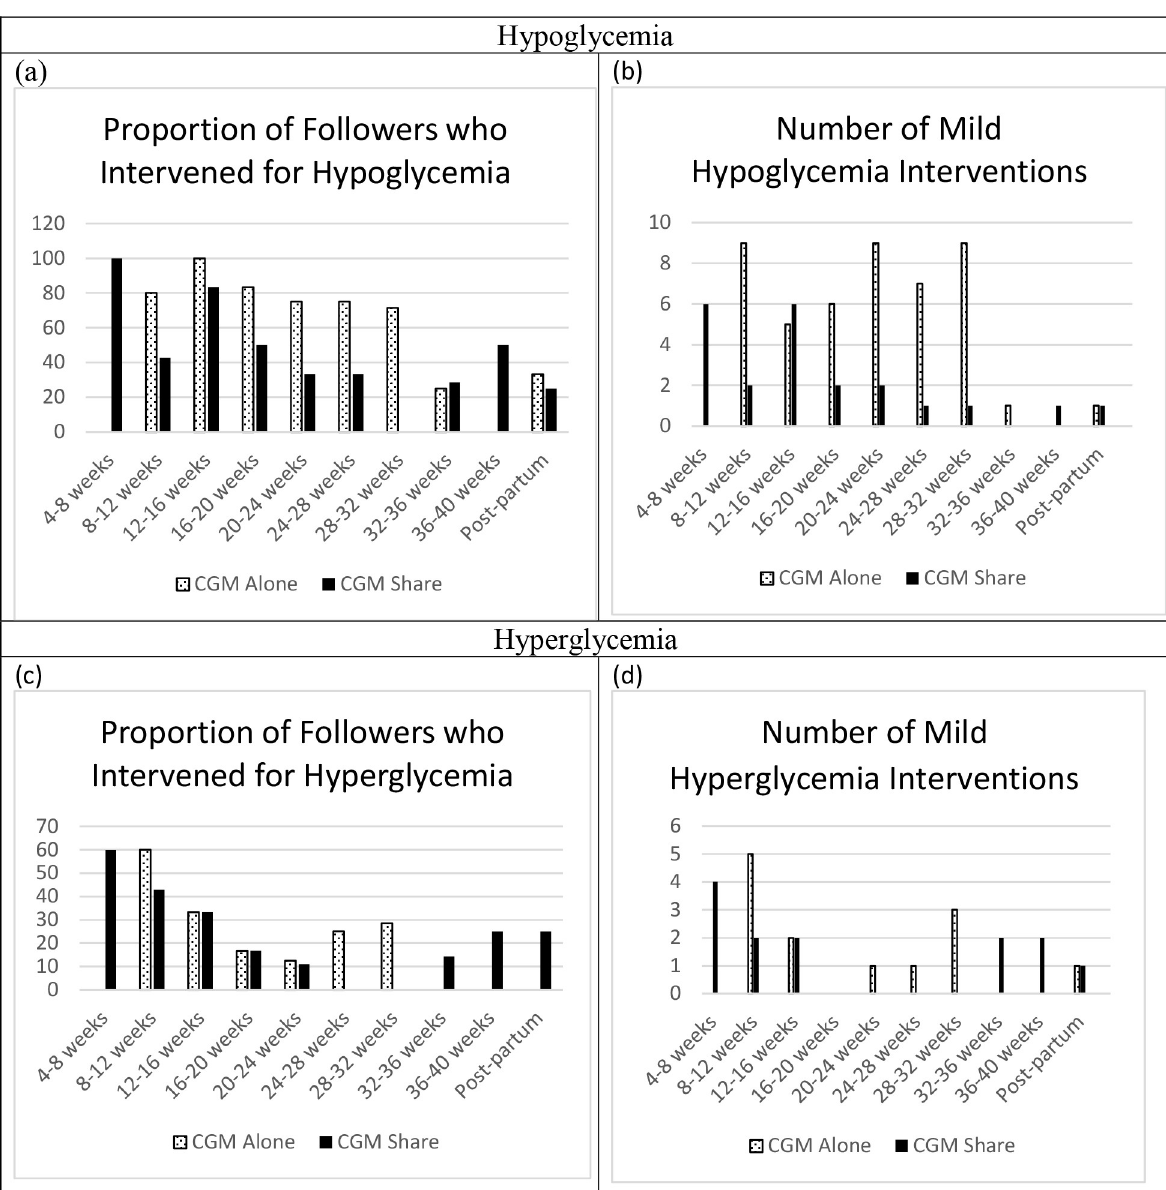
Fig 3. Absolute number of follower interventions. Fig 3A is the proportion of followers who intervened for hypoglycemia on behalf of their pregnant partners. Fig 3B is the number of mild hypoglycemic interventions performed by followers on behalf of their pregnant partners. Fig 3C is the proportion of followers who intervened for hyperglycemia on behalf of their pregnant partners. Fig 3D is the number of mild interventions for hyperglycemia performed by followers on behalf of their pregnant partners.